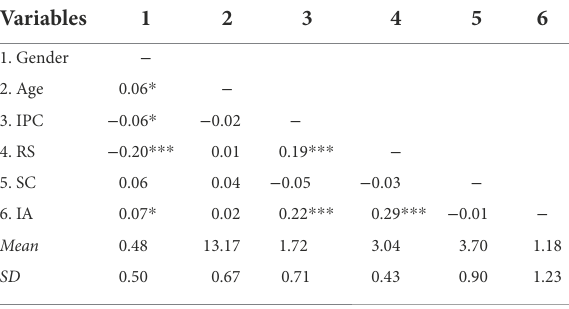
TABLE 1 Descriptive statistics and correlations for all